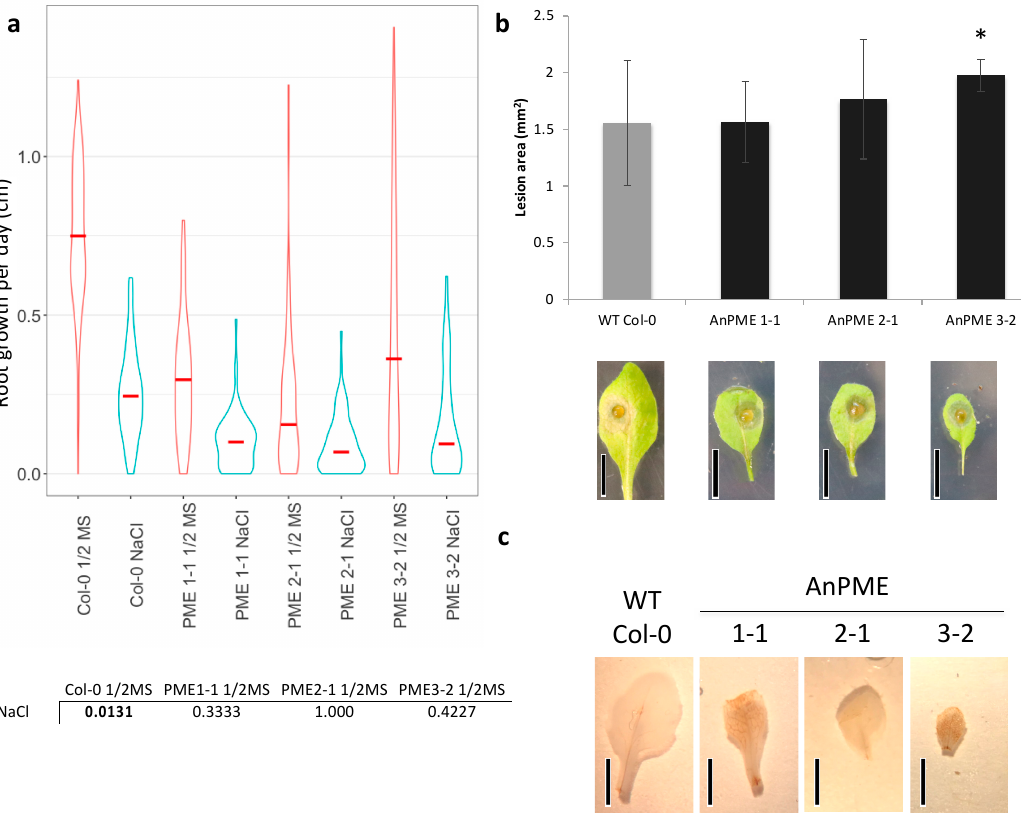
Figure 4. Plant response to stresses. ( a ) Root growth comparison between plants grown in optimal conditions (1/2MS) and salt stress (100 mM NaCl). Red lines indicate median values. Below box plot, adjusted p -values (Bonferroni) comparing the same plants grown on 1/2MS and salt. Bold values indicate statistical significance ( p < 0.05, ANOVA; n ≥ 75); ( b ) Lesion areas 48 h after inoculation with B. cinerea ( n = 12); ( c ) Uninoculated rosette leaves stained with 3,3 ′ -diaminobenzine showing ROS accumulation in AnPME plants. Error bars represent standard deviation. Asterisks indicate statistical significance ( p < 0.05, student’s t-test). Scale bars = 1 cm.